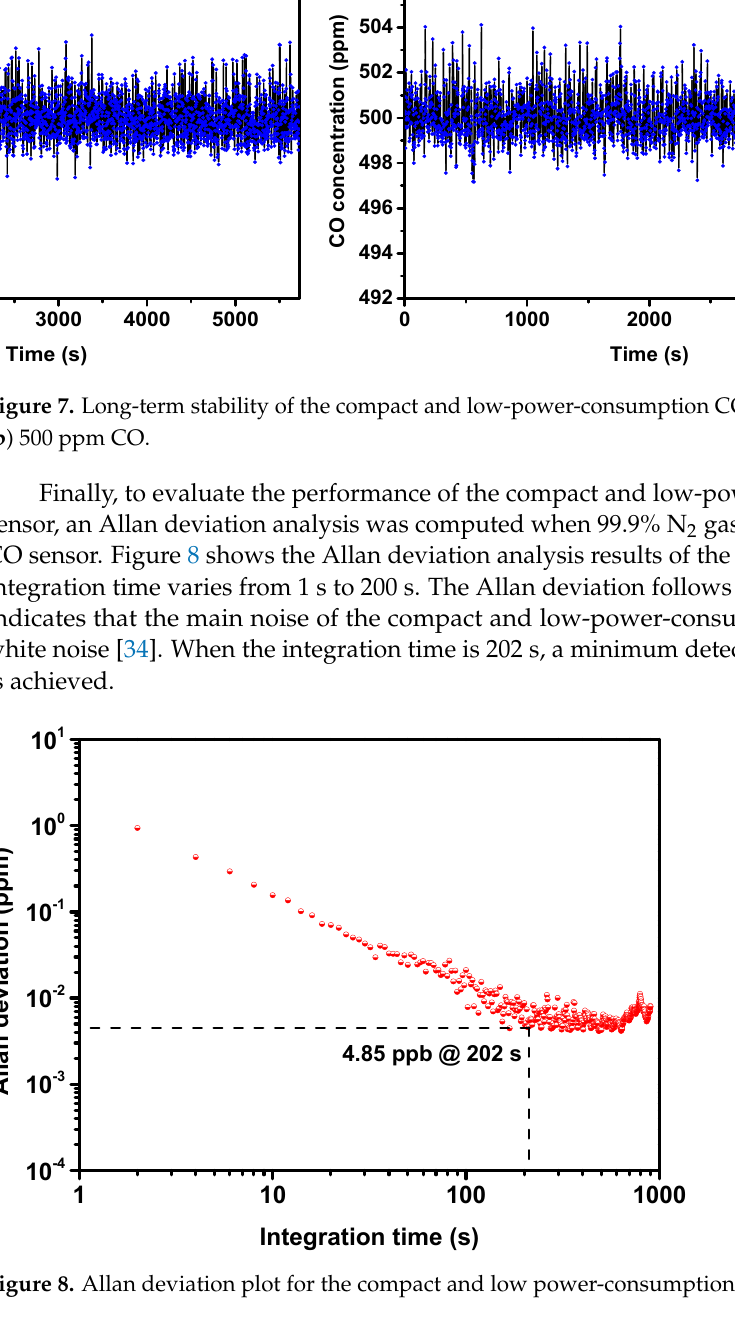
Figure 8. Allan deviation plot for the compact and low power-consumption CO sensor.